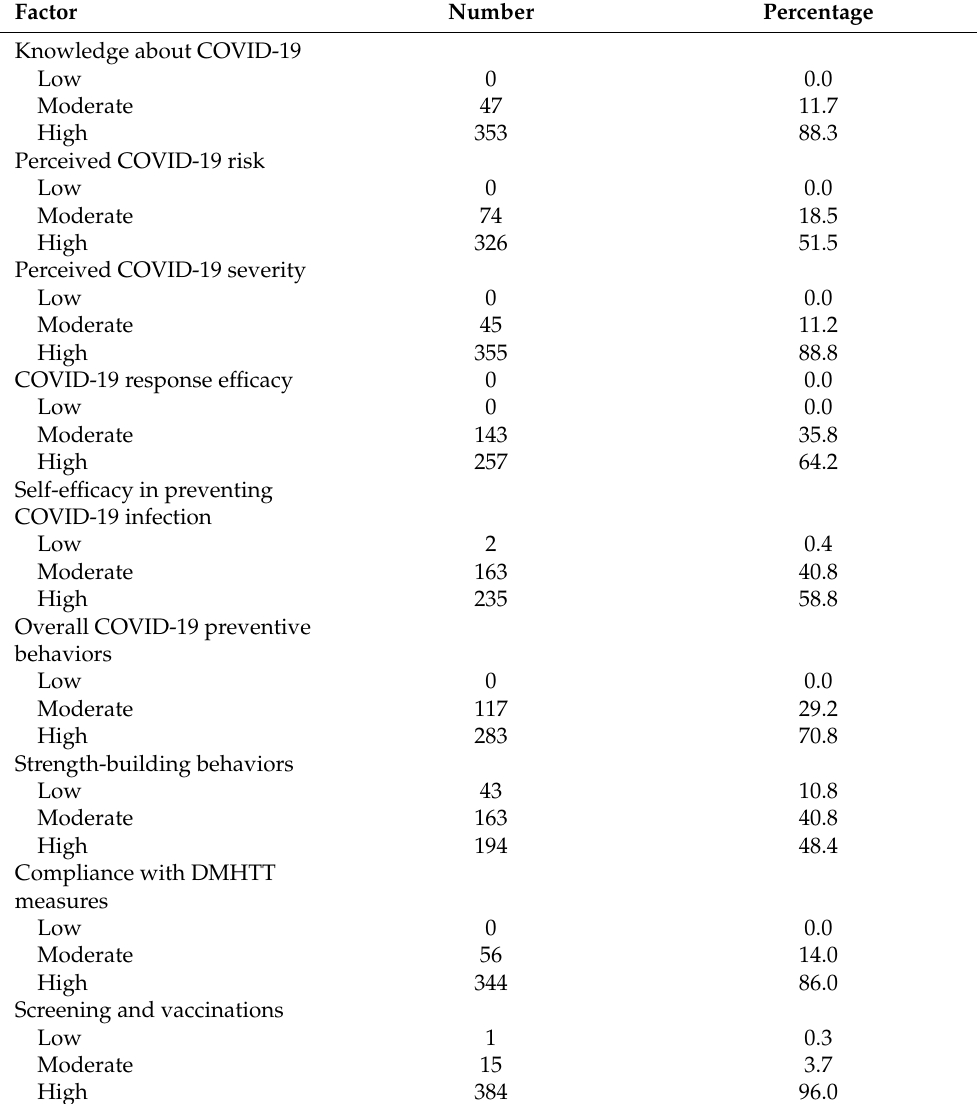
Table 1. Knowledge about COVID-19, protection motivation, and COVID-19 preventive behaviors of the study